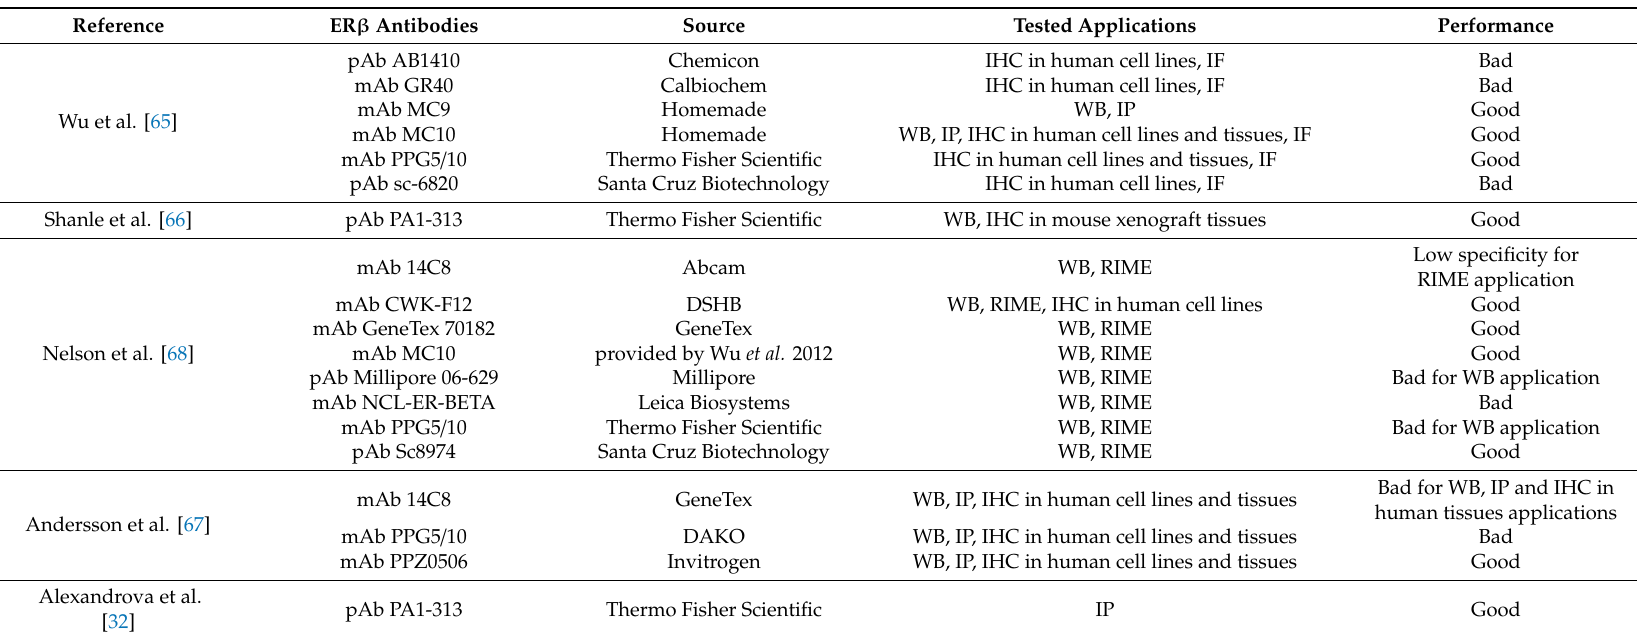
Table 1. Details of the main ER β antibodies applications and